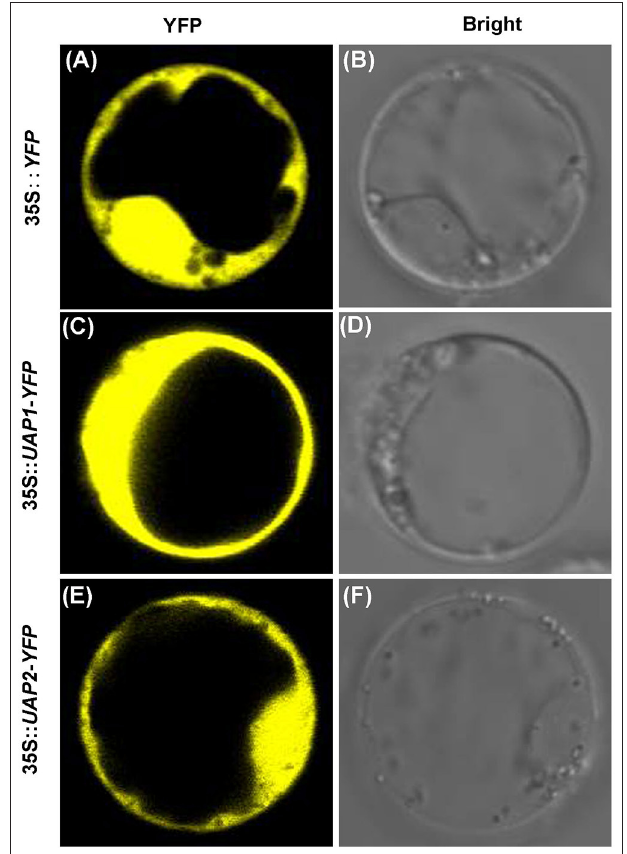
FIGURE 5 | Subcellular localization of UAP1 and UAP2 proteins. Rice protoplast transformed with (A,B) empty vector 35S:: YFP as control,